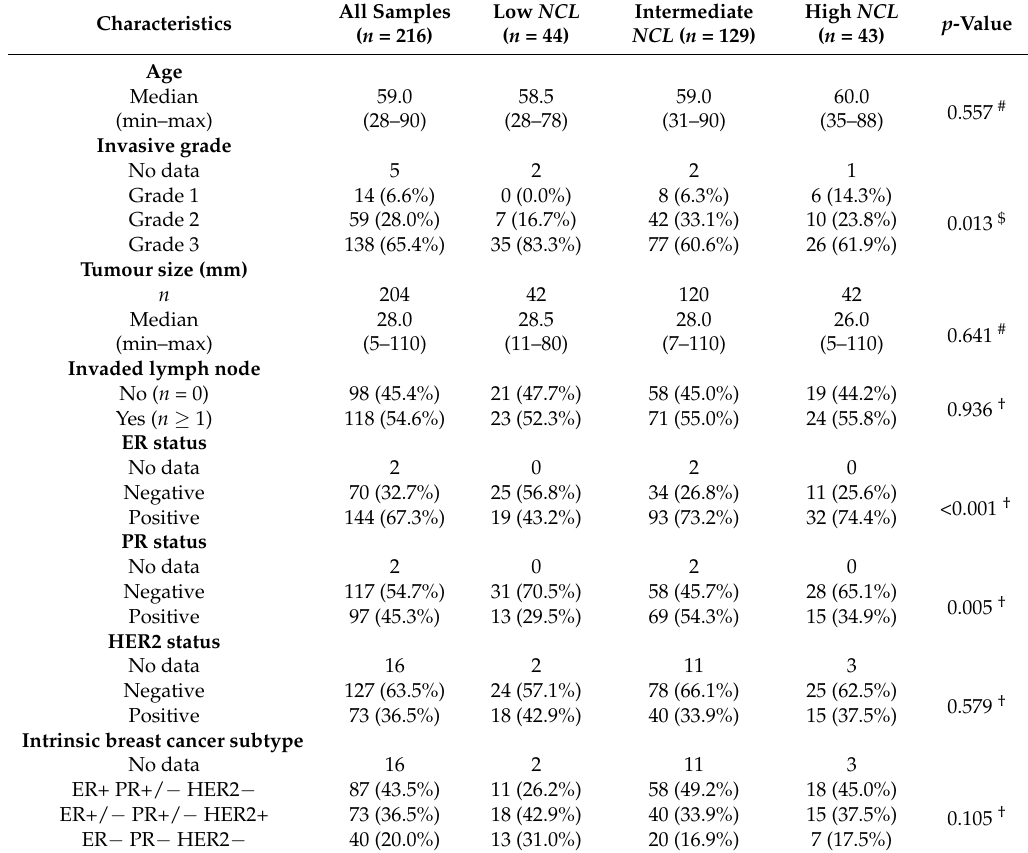
Table 1. Population distribution of Dundee series regarding nucleolin ( NCL ) expression levels.